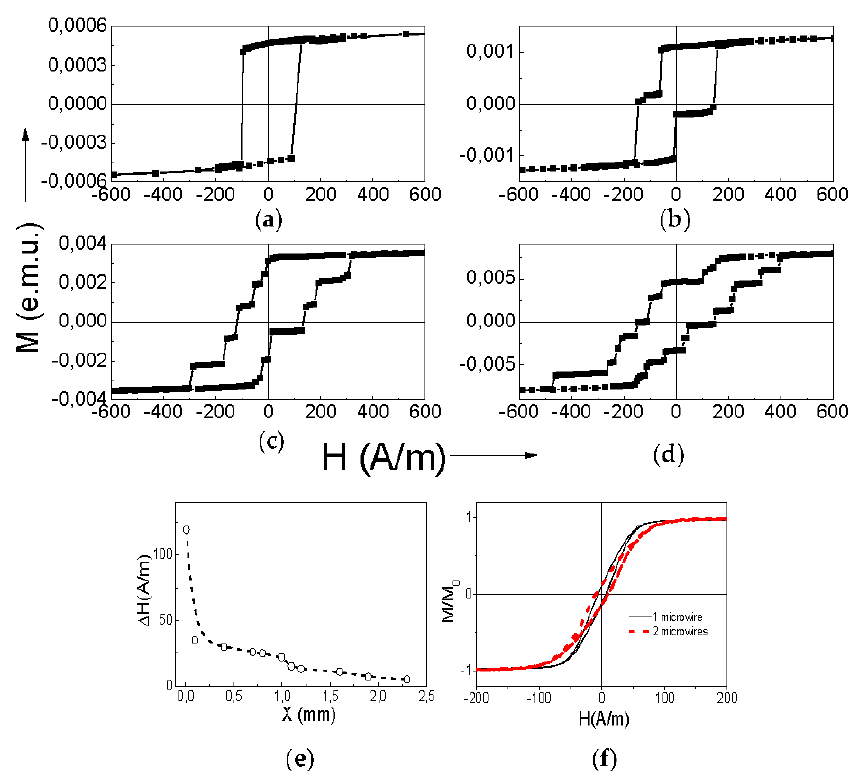
Figure 9. Hysteresis loops of a single glass-coated Fe 65 Si 15 B 15 C 5 amorphous microwire ( d = 12.6 µ m) ( a ) and of arrays consisting of 2 ( b ), 5 ( c ), and 10 ( d ) Fe 65 Si 15 B 15 C 5 microwires, dependence of the hysteresis loop splitting on the distance between Fe 65 Si 15 B 15 C 5 microwires in the two-microwires array ( e ), and hysteresis loop of the array consisting of two Co 67 Fe 3.9 Ni 1.5 B 11.5 Si 14.5 Mo 1.6 glass-coated microwires ( f ). The line in ( e ) is just a guide to the eyes; ( a – e ) are reprinted with permission from [55]; ( f ) is reprinted with permission from [50].